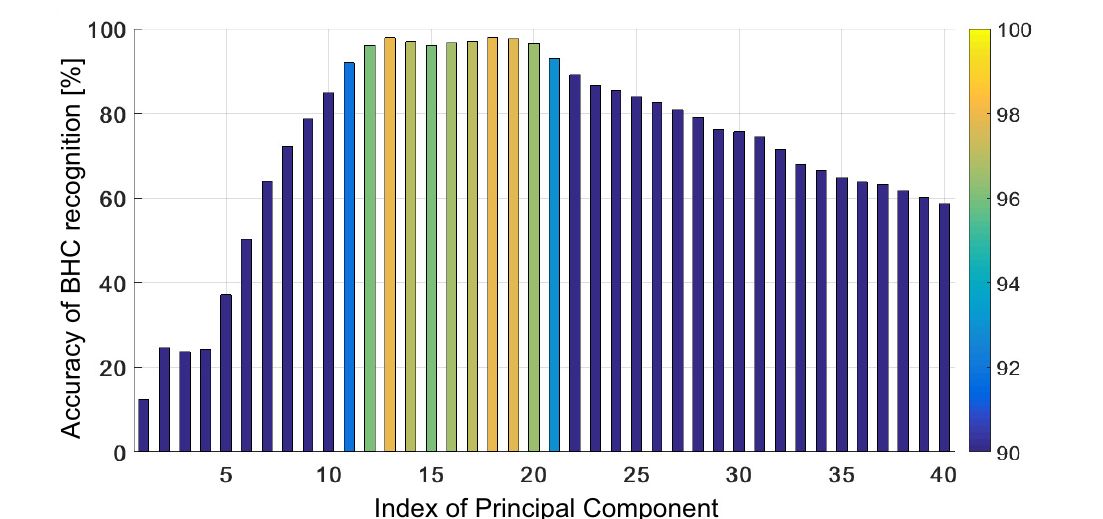
Figure 5. Accuracy of BHC recognition (average) versus PCs for the KSVM with the untrained GRBF.